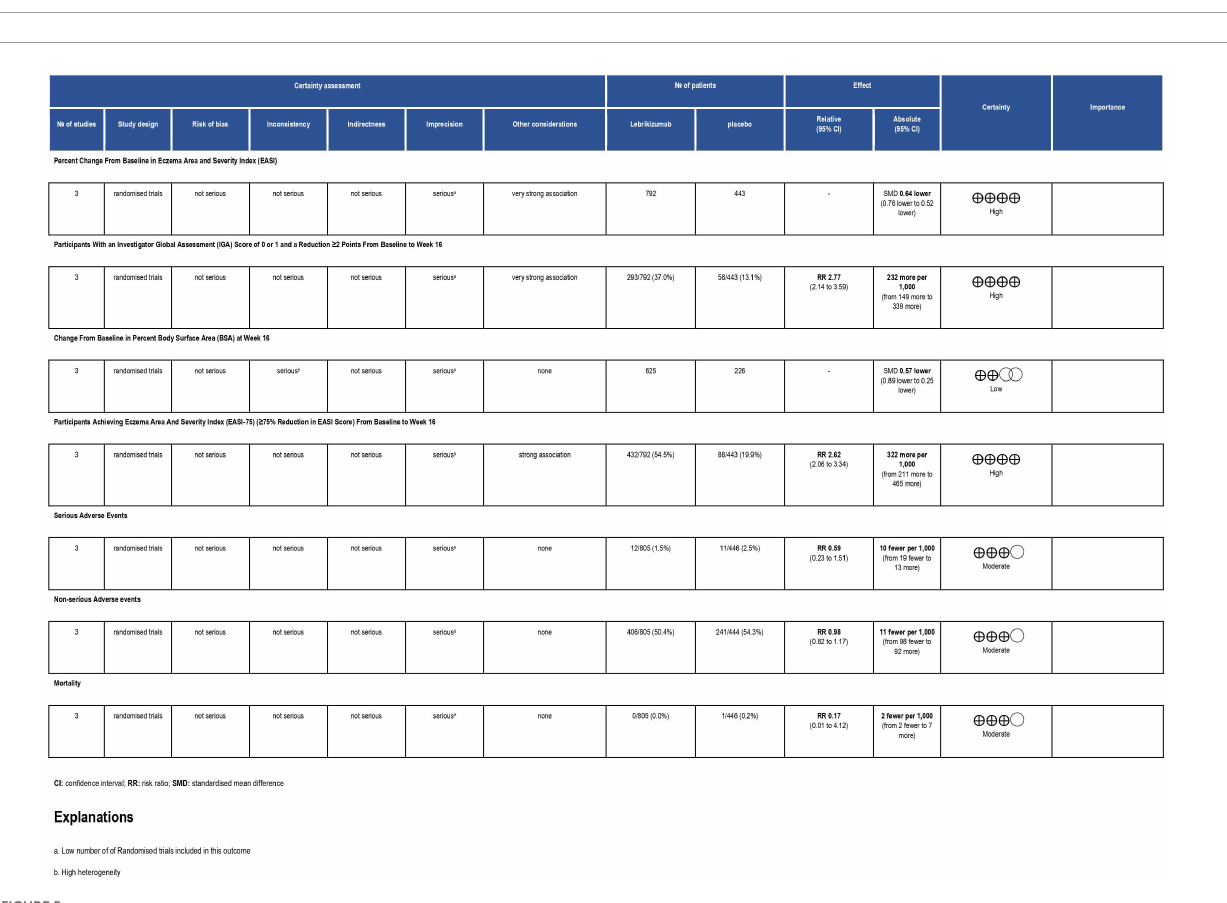
FIGURE5 Grading of Recommendations Assessment, Development and Evaluation (GRADE) evidence profile. CI, confidence interval; RCT, randomized controlled trial; RR, risk ratio.